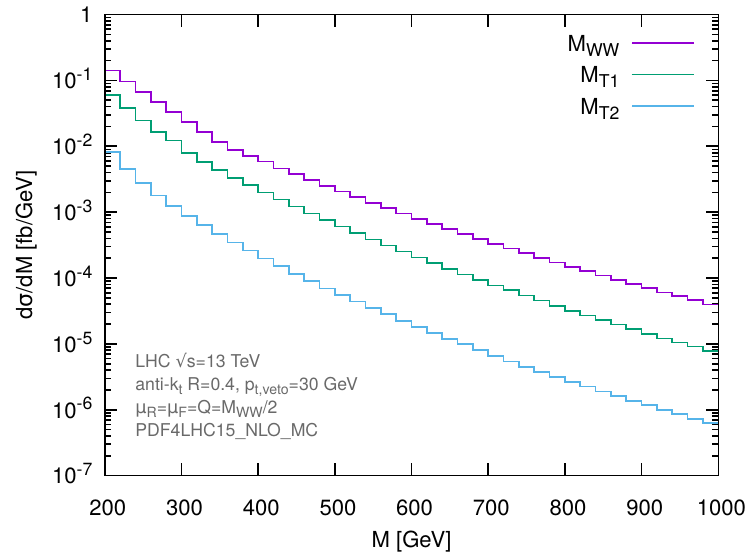
Figure 6 . The distributions in M = M WW ; M T 1 ; M T 2 for the gg incoming